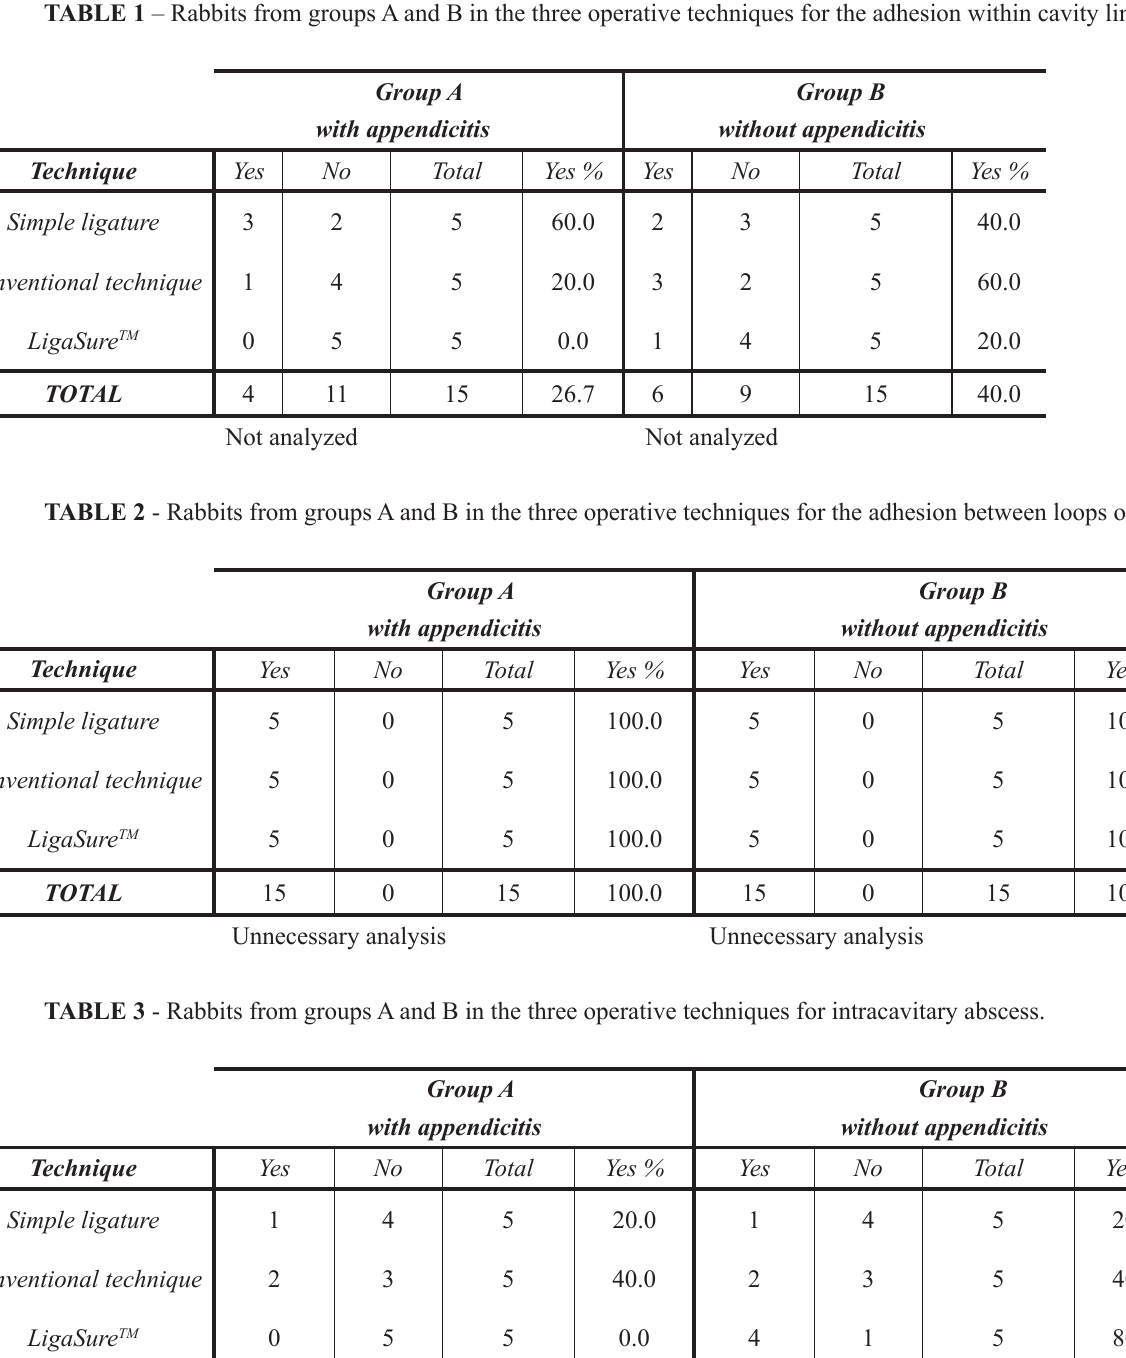
TABLE 1 – Rabbits from groups A and B in the three operative techniques for the adhesion within cavity line sutured.